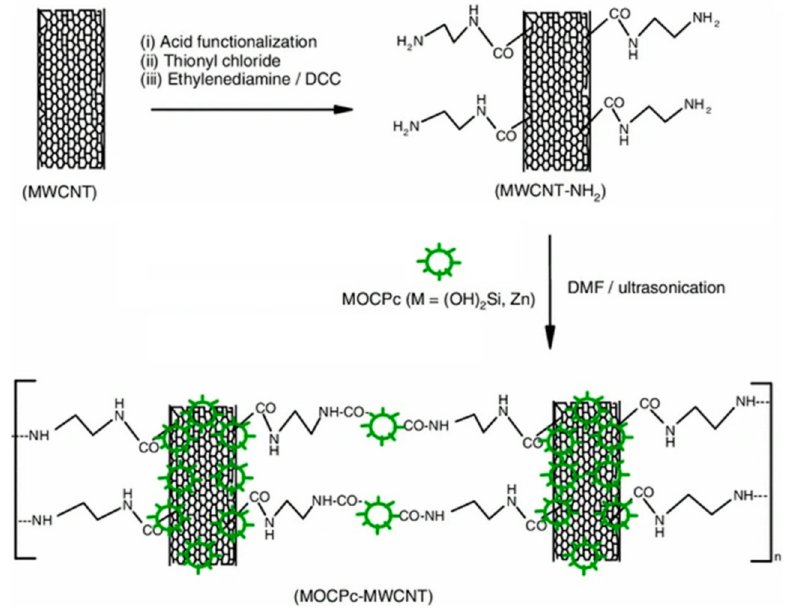
Figure 4. Synthetic route for the MOCPc–MWCNT hybrid. Reproduced from [58] with the permission of the American Chemical